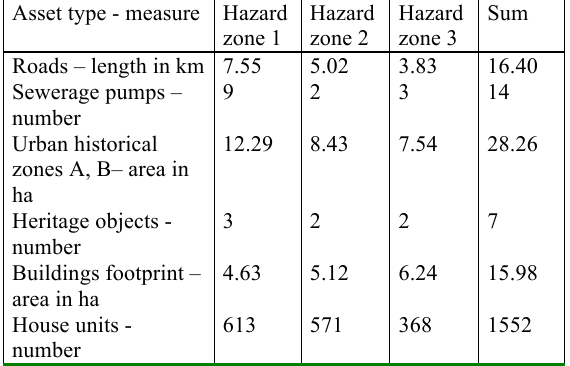
Table 2. Assets located in the hazards zones